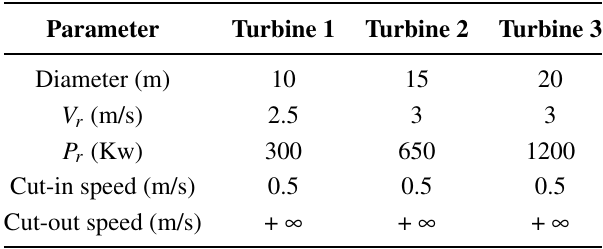
Table 3. Parameters of the three different turbines utilised for the